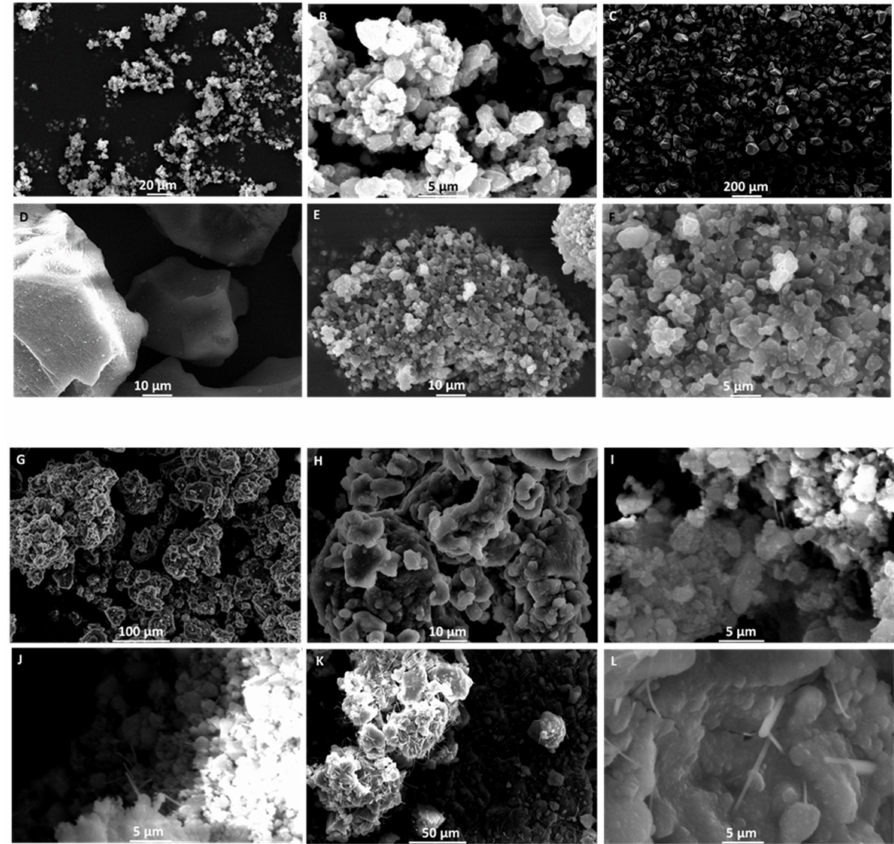
Figure 5. Scanning electron microscopy (SEM) images to understand the morphology of solids SNEDDS; Blank solid SNEDDS using Syloid 244 FP 2:1 w / w (SS1, ( A , B ), Bar: 20 and 5 µ m), blank solid SNEDDS using Syloid XDP 3050 2:1 w / w (SS2, ( C , D ), Bar: 200 and 10 µ m), NFX—BNZ SNEDDS adsorbed on Syloid 244 FP 2:1 w / w (NBSS1, ( E , F ), Bar: 10 and 5 µ m), NFX—BNZ SNEDDS adsorbed on Syloid XDP 3050 2:1 w / w (NBSS2, ( G , H ), Bar: 100 and 10 µ m), NBSS1 exposed in acidic media (0.1 M HCl for 90 ◦ C) and dried (( I , J ), Bar: 100 and 10 µ m) and NBSS2 exposed in acidic media (0.1